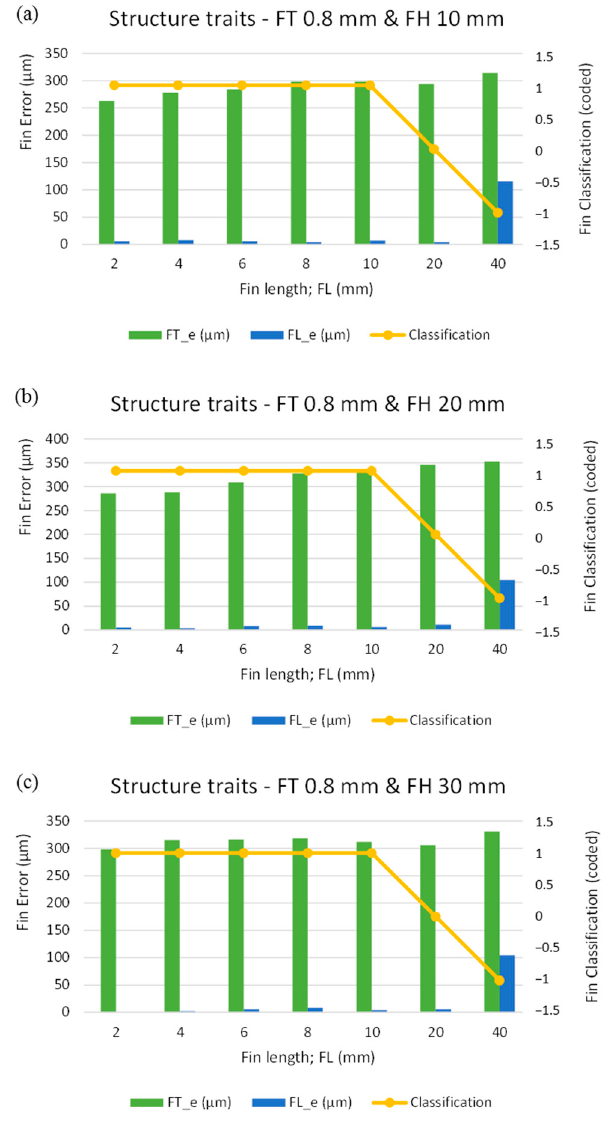
Figure 13. Graphical analysis of structure traits in the fourth phase of experimentation with designed fin thickness (FT_d) of 0.8 mm: ( a ) FH 10 mm, ( b ) FH 20 mm, and ( c ) FH 30 mm.